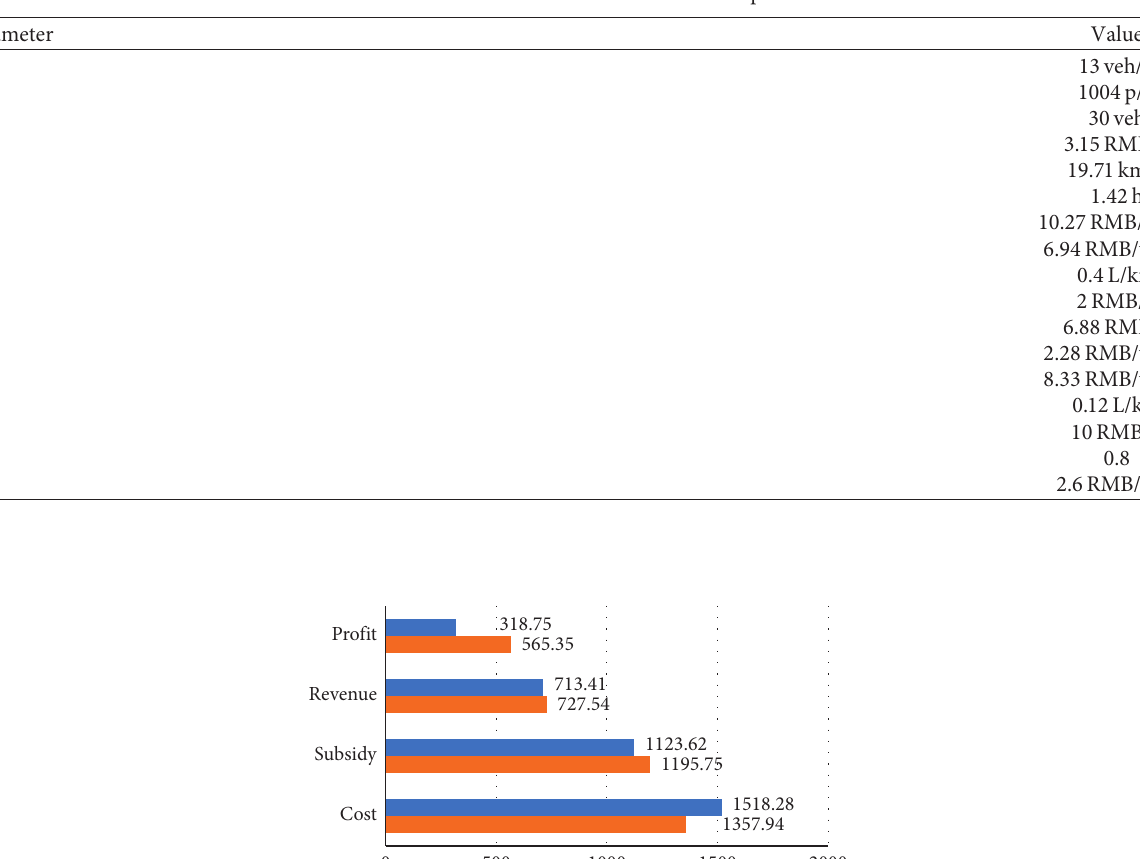
Figure 4: Case study bus route and demand Table 2: Parameters of the studied bus route in current operational condition.